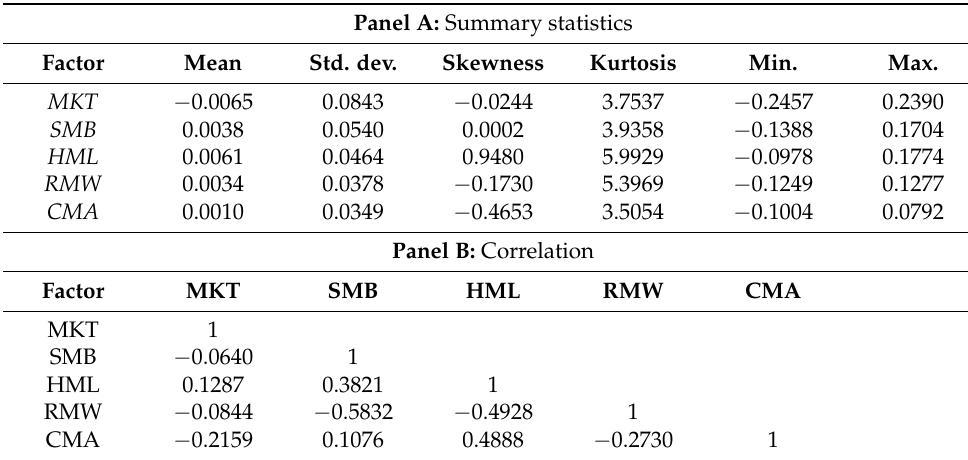
Table 2. Summary statistics for Fama–French factors of Vietnamese stocks. Panel A: Summary